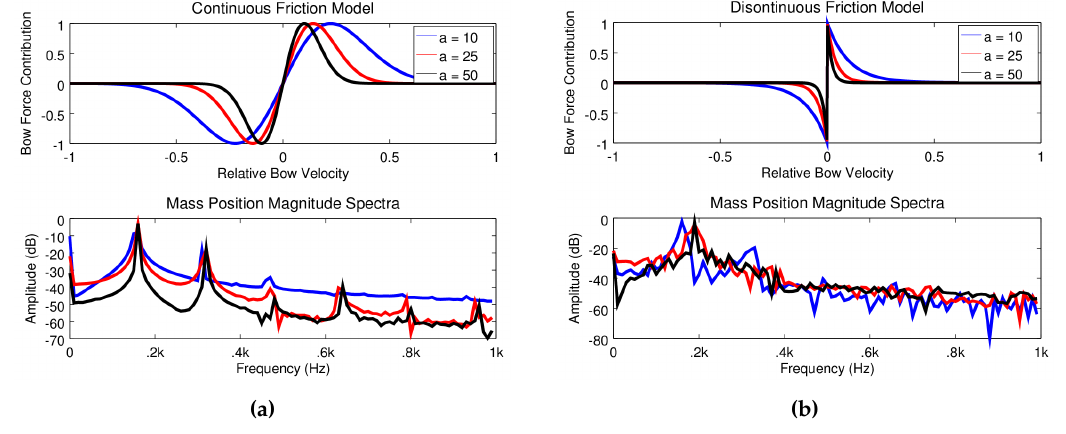
Figure 8. RK4 solving Equations (25) using ( a ) the continuous friction model in Equation (24) and ( b ) Equation (26). ( a ) Differentiable friction model; ( b ) Discontinuous friction